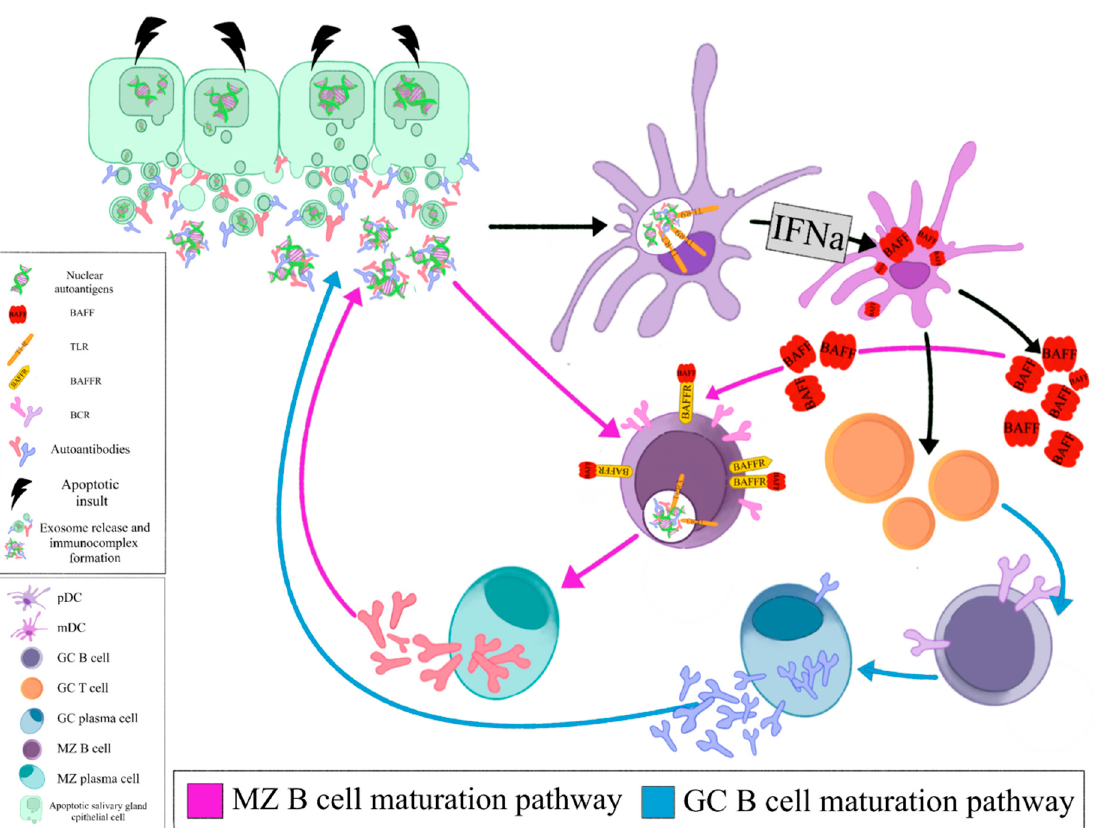
Figure 1. Opsonized epithelial apoptotic particles and ICs containing nuclear autoantigens bind to plasmacytoid DCs (pDCs) and RF B cells via TLRs and Fc receptors, respectively. TLR activation in pDCs leads to IFNa release that subsequently stimulates myeloid DCs (mDCs) to produce BAFF. The same apoptotic particles and ICs also bind to RF B cells via TLR and BCR, respectively. TLR activation in B cells results in enhanced BCR mediated signaling and upregulation of BAFF-R. BAFF, secreted by mDCs, further upregulates TLR expression, favors B cell survival, promotes immunoglobulin class- switching and plasma cell di ff erentiation (MZ B cell maturation pathway). The activated mDCs also act as antigen presenting cells to T cells that help B cell responses (GC B cell maturation pathway). (pDC: plasmacytoid dendritic cell, mDC: myeloid dendritic cell, GC: germinal center, MZ: marginal zone, BAFF: B cell activating factor, TLR: Toll like receptor, BAFFR: BAFF receptor, BCR: B cell receptor, IFNa: interferon a).